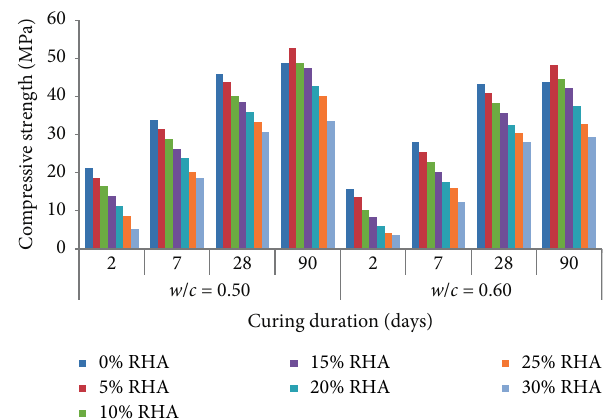
Figure 5: Compressive strength verses curing duration for RHA-blended